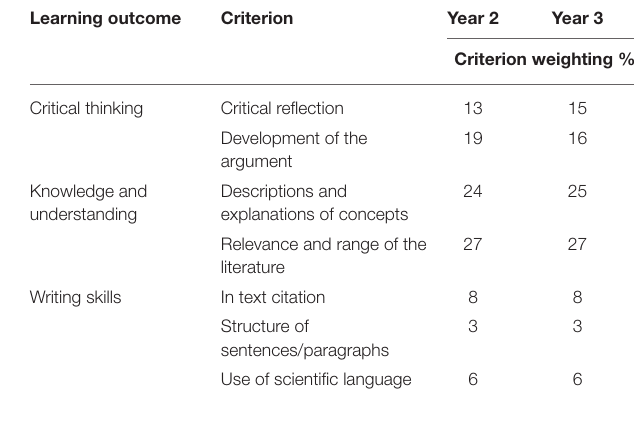
TABLE 6 | Data-derived criterion weightings (essay-based questions in